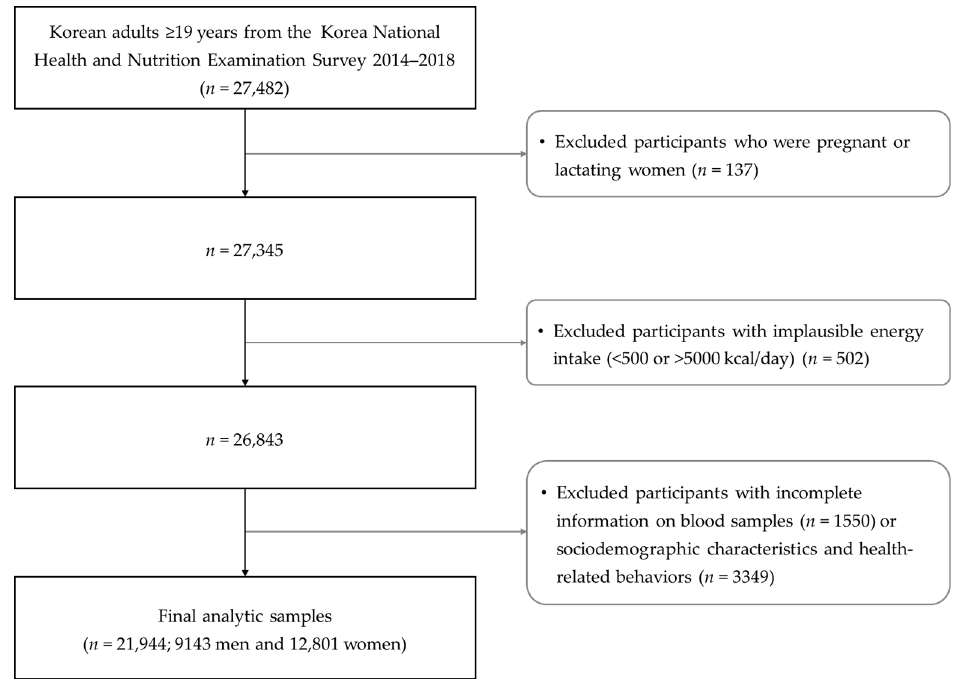
Figure 1. Flowchart of the study population.